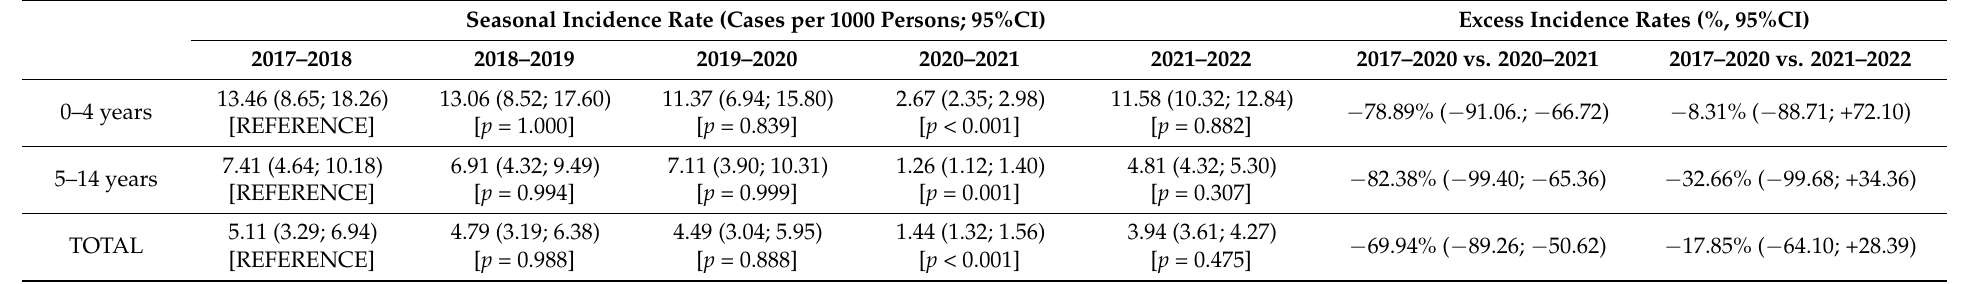
Table 2. Incidence rates (cases per 1000 persons) for influenza-like illnesses (ILI; InfluNet surveillance system of the Italian National Health Institute), and corresponding excess incidence rates calculated for 2020–2021 and 2021–2022 compared to the averages for 2017–2020. Comparisons between seasonal incidence rates were performed by means of analysis of the variance (ANOVA) with post-hoc test of Dunnet, assuming reporting season 2017–2018 as the reference